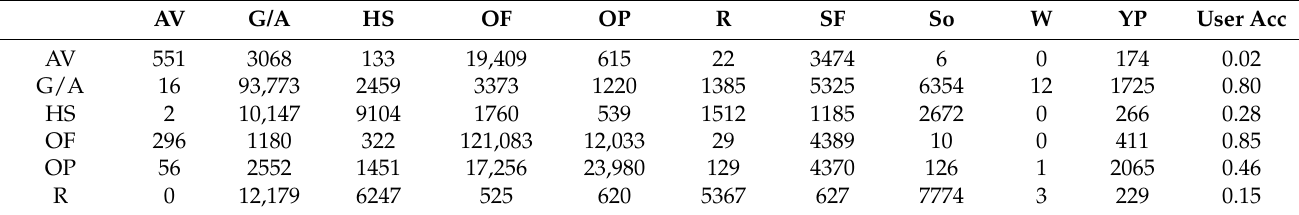
Table A4. Confusion matrix for the validation set using the MS + SAR random forests. Rows show predicted classes while column, ground truth classes. LULC abbreviations: AV, aquatic vegetation; G/A, grasslands/agriculture; HS, human settlements; OF, old-growth forests; OP, old-growth plantations; R, roads; SF, secondary forest; So, soil, W, water; YP, young plantations. User acc stands for user’s accuracy, while Prod acc for producer’s